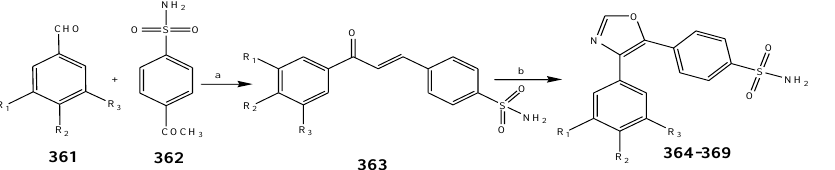
a = NaOH/EtOH/Reflux, b = NH 2 OH/CH 3 CONa. 364 :R 1 = H,R 2 = OMe,R 3 = H; 365 :R 1 = OMe,R 2 = Scheme 30. Synthesis of 1,2-oxazoles 364 – 369 .